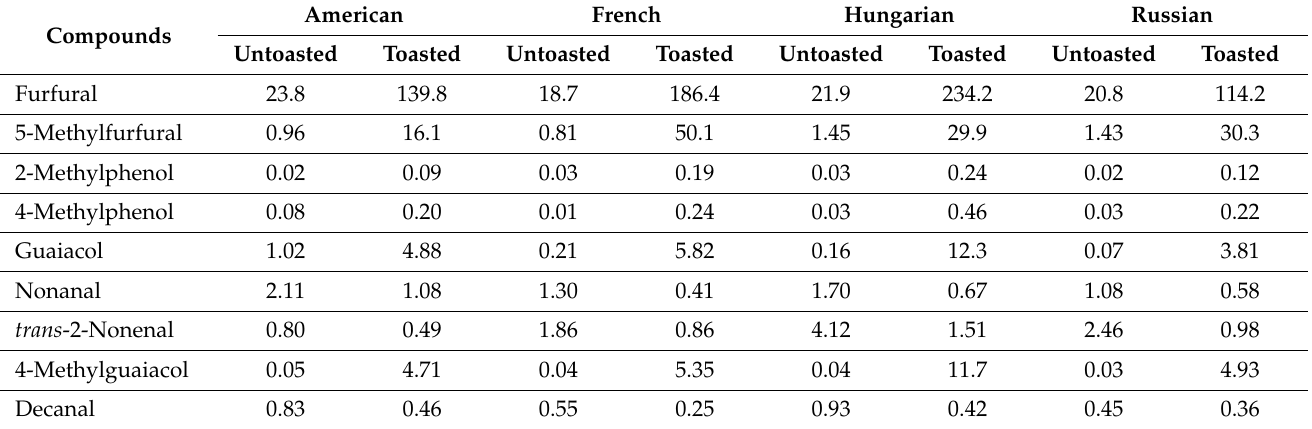
Table 3. Concentration ( µ g/g) of some oak wood-derived volatile compounds in toasted and un- toasted American, French, Russian, and Hungarian oak species